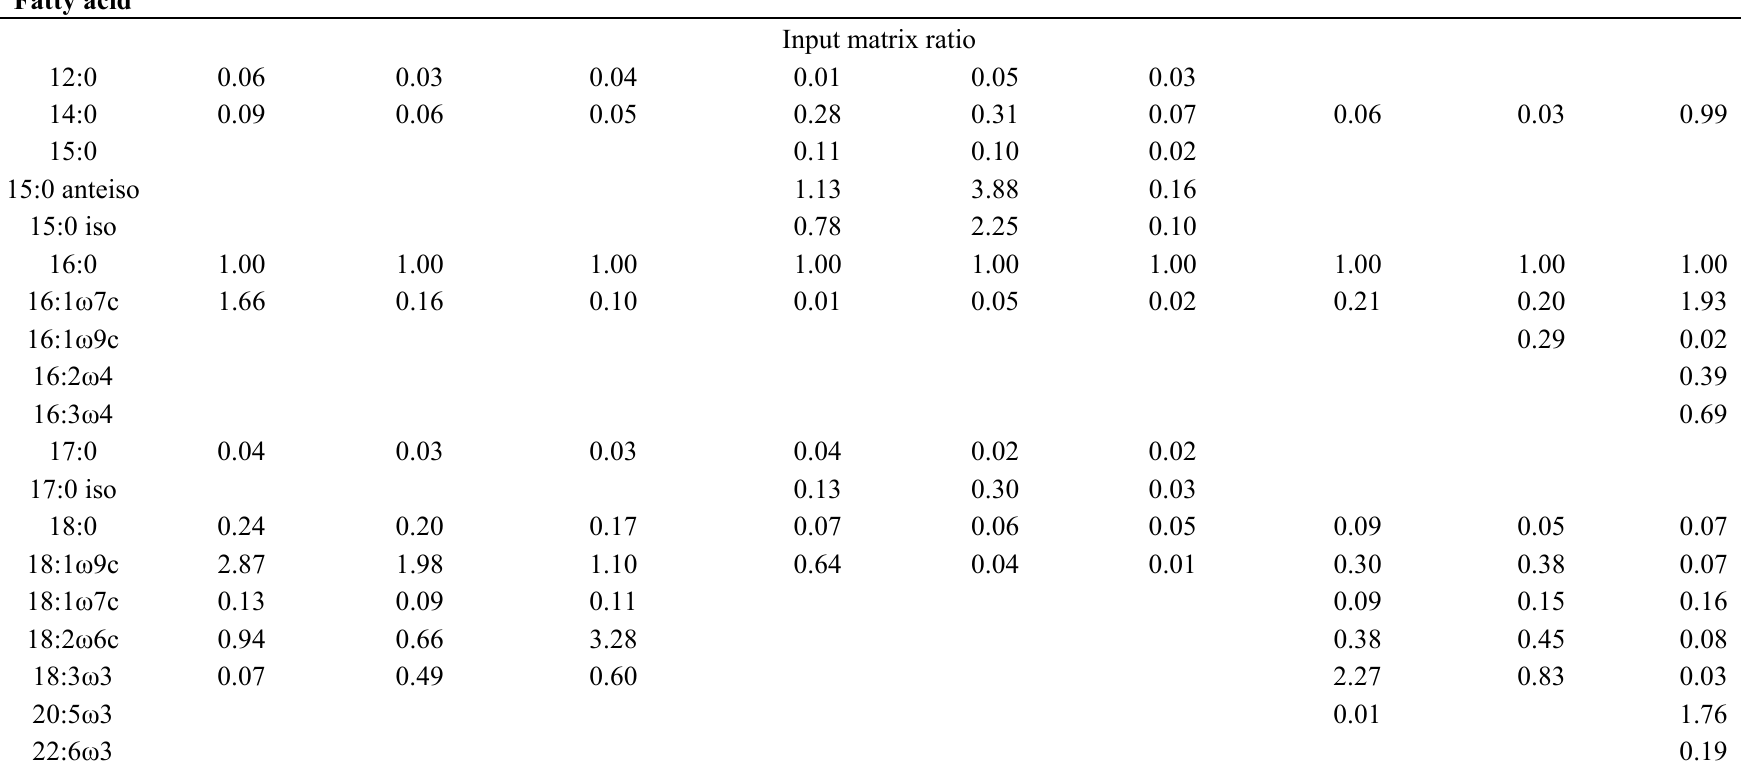
Table 3. Average PLFA composition (referred to 16:0) for bacteria, algae and fungi isolated in the samples collected in the studied temporary ponds and cultured under standard conditions. PLFA present at a very low concentration (less than 1%) or occurring in single species were